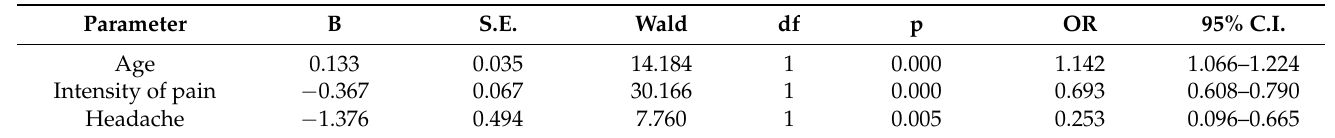
Table 3. Parameters associated with analgesic consumption based on the final model of the logistic